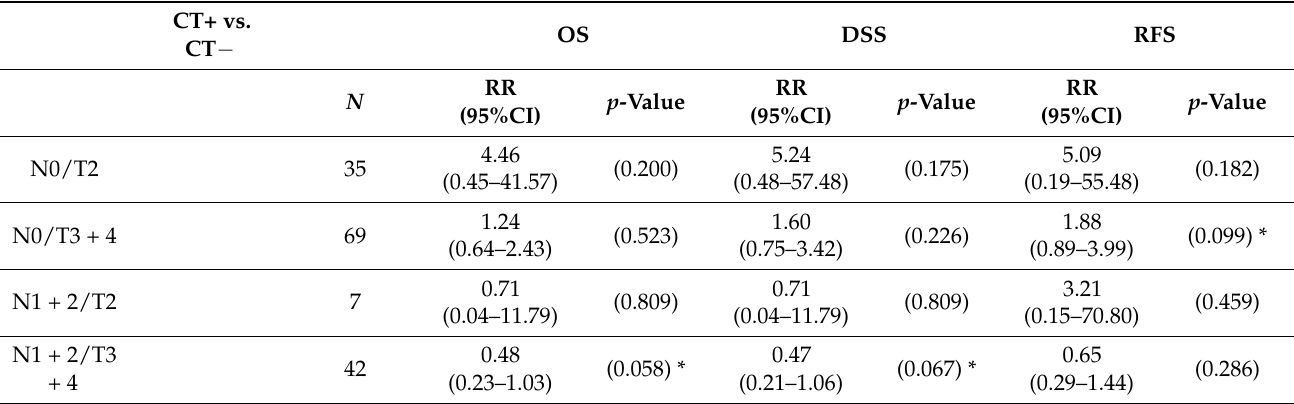
Table 4. Multivariate Cox’s regression analysis: Association between chemotherapy and prognosis stratified by nodal stage and tumor stage (adjusted for the immune markers CCL2, CD68, and CD163). CT+ vs.